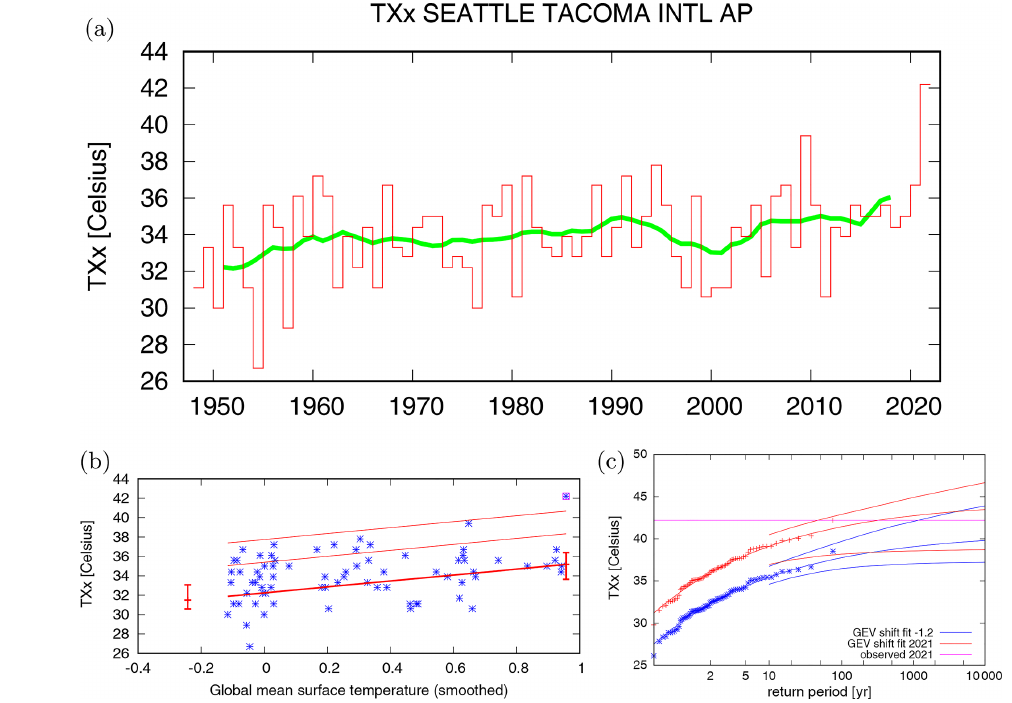
Figure 10. As Fig. 9 but for the station data at Seattle–Tacoma International